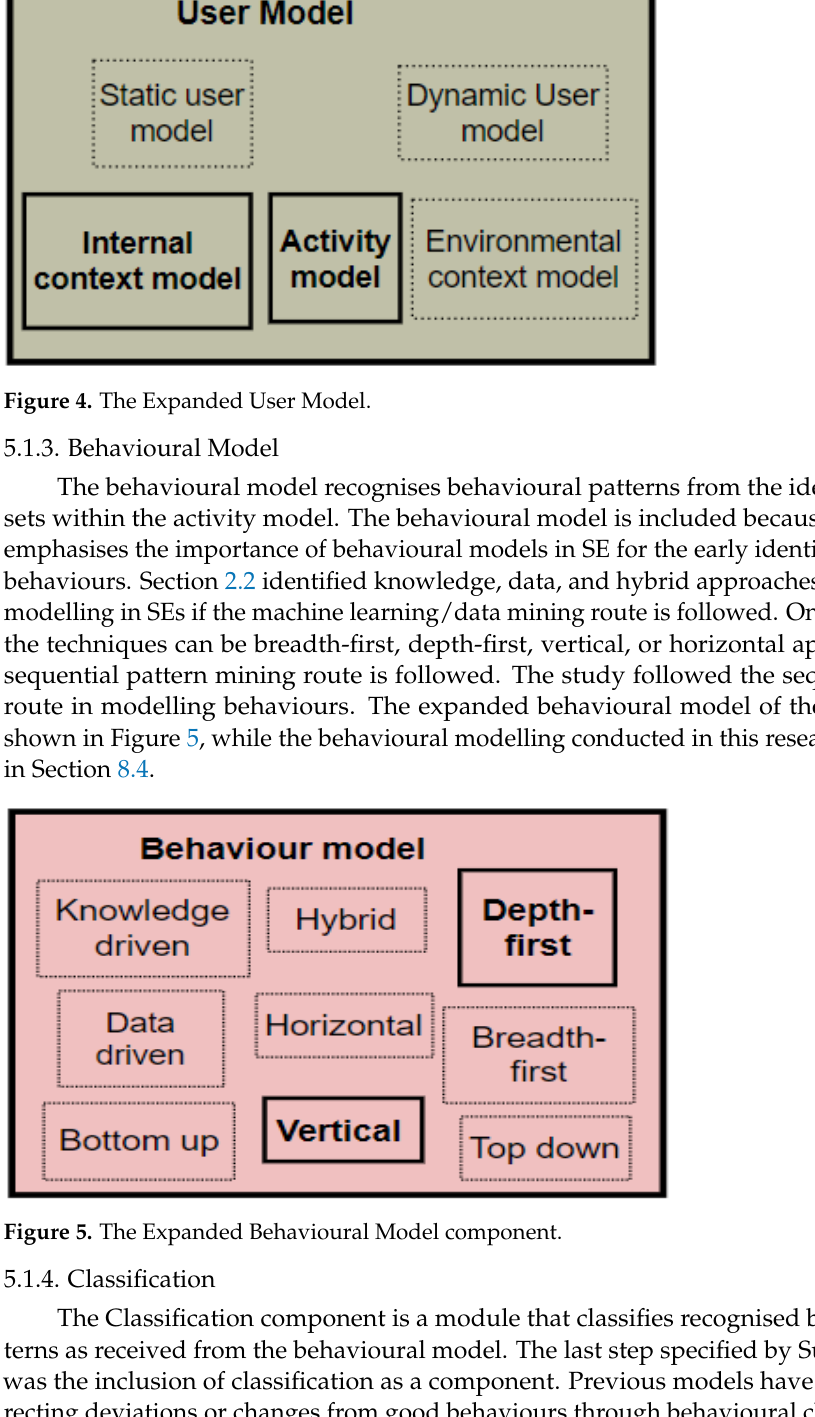
15 of 52 Figure 3. The Expanded SE Component of the PBC Model. 5.1.2. User Model The user model provides information about users of SEs. The following theories mo- tivated the inclusion of a user model in the PBC model. (i) The SCT emphasizes the effect of personal factors, such as cognitive, affective, and biological events, as determinants of behaviour [96]. (ii) The SmartWork model, where the health, emotion, stress, and cogni- tive aspects of workers were captured within the worker-centric AI block. (iii) In SE, Vla- chostergiou et al. [103] emphasized the significance of the internal context of a user in producing observable behaviour. These are essential aspects of user modelling, but other aspects must be captured. In this study, the user model consists of several sub-models, such as SUM, DUM, internal context, activity context, and environmental context models. The details of these sub-mod- els have been explained in a previous publication [31]. For this study, the specific output